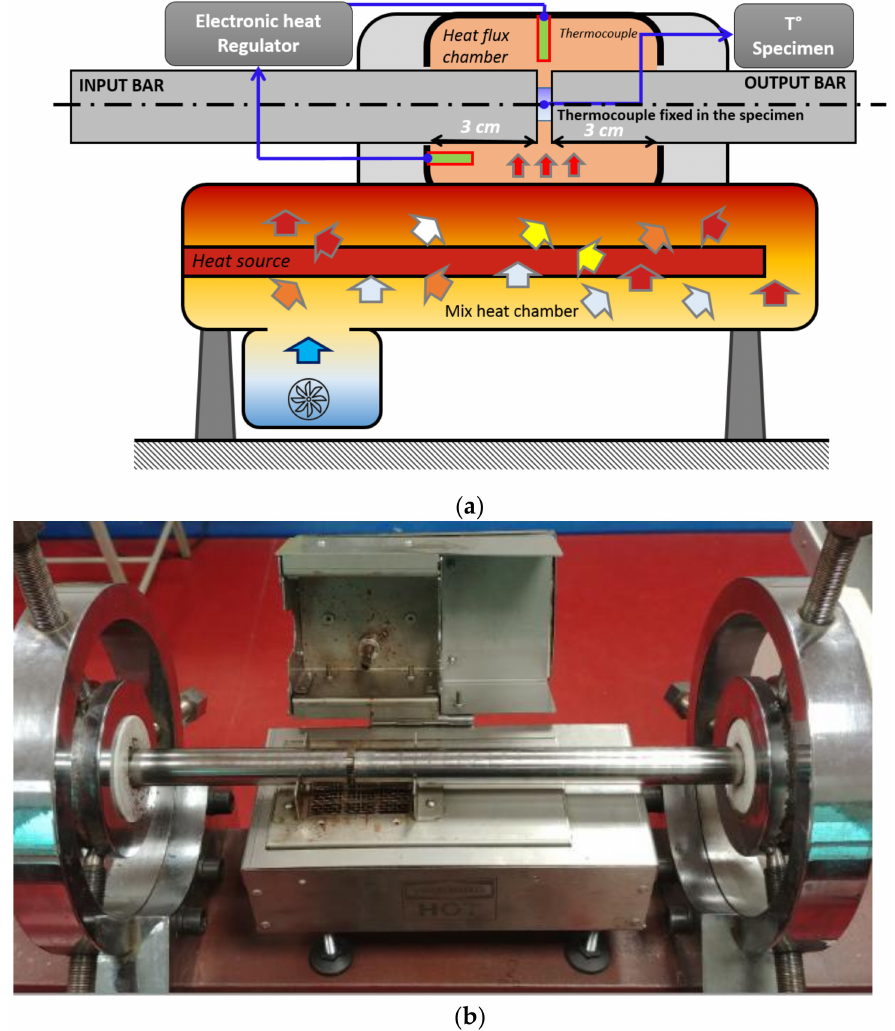
Figure 2. Description (adapted from [21]) ( a ) and picture ( b ) of the furnace used for high temperature dynamic compression